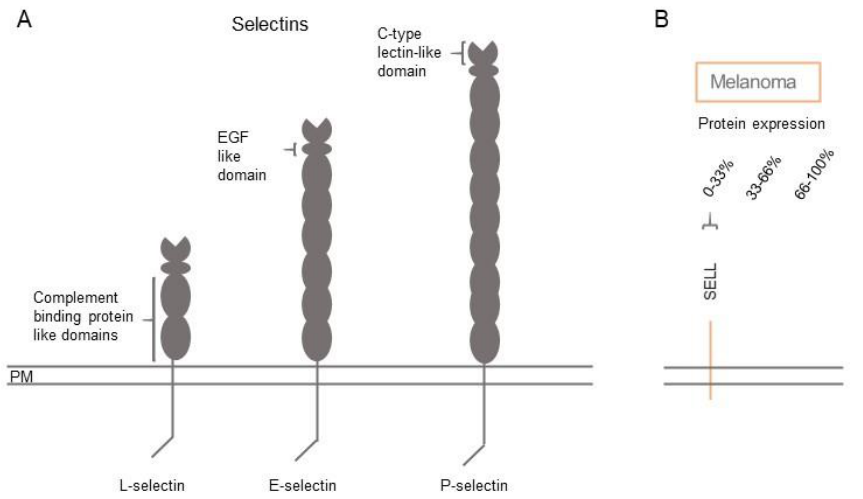
Figure 7. Schematic structure of selectins and protein expression in melanoma. ( A ) Extracellular representation of the extracellular binding domains of the selectin family. ( B ) Selectin protein expression on melanoma cells obtained from the Human Protein Atlas (immunohistochemistry staining). Staining intensities are estimated based on the percentage of patient samples positively stained for the respective CAM and classified into low (0 – 33% of patients), medium (33 – 66% of patients), and high expression (66 – 100% of patients). See also Table S4.